Question: Looking at the figure, what chart type is it?
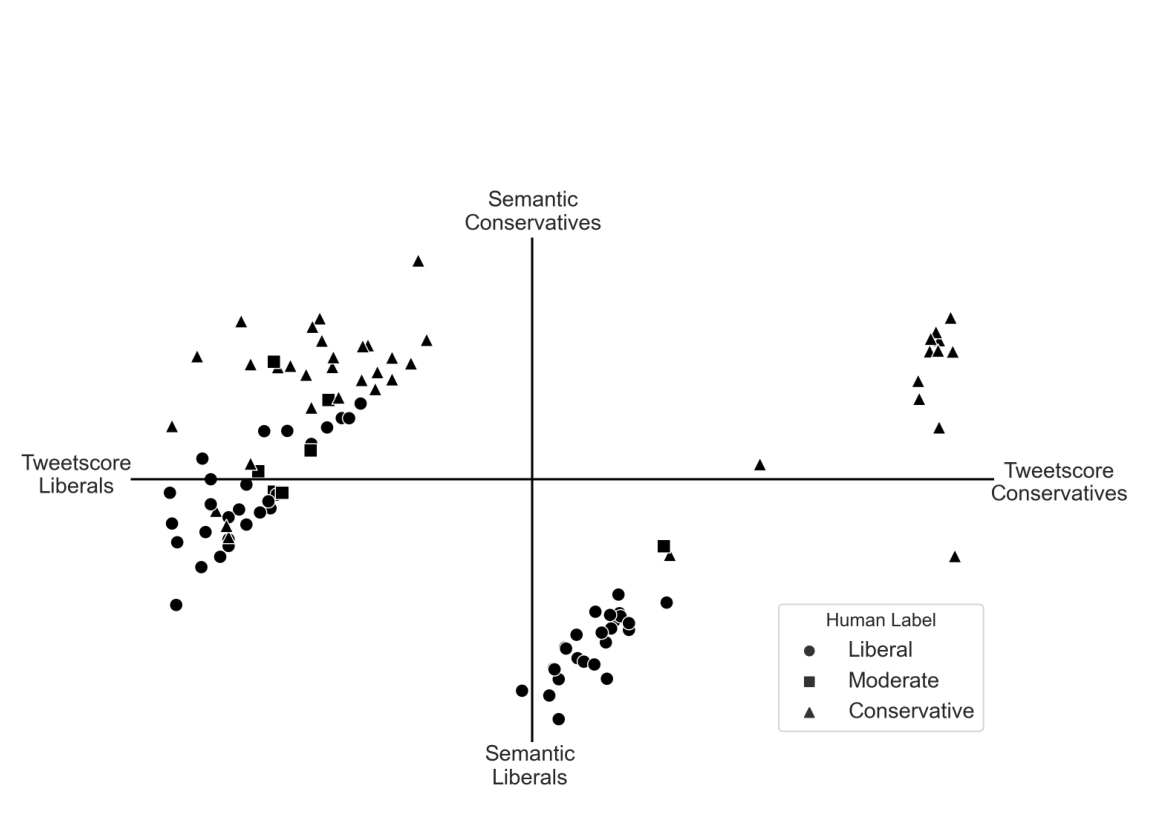
Answer: scatter